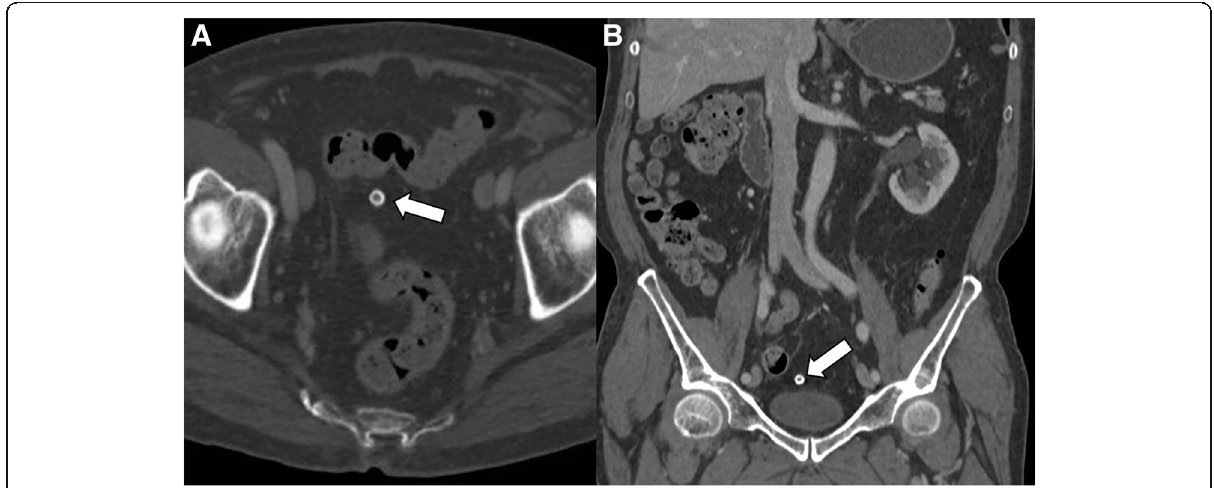
Fig. 8 Chronic calcified, amputated epiploic appendage in an 81-year-old man. a Axial contrast-enhanced CT image (bone window) shows a calcified, ring-like lesion (arrow) medial to the sigmoid colon which could be mistaken for a mesenteric lymph node or drop gallstone. b Coronal reformatted CT image of the same patient depicts the peritoneal loose body in pelvic cavity, likely due to chronic infarcted epiploic appendage (arrow)